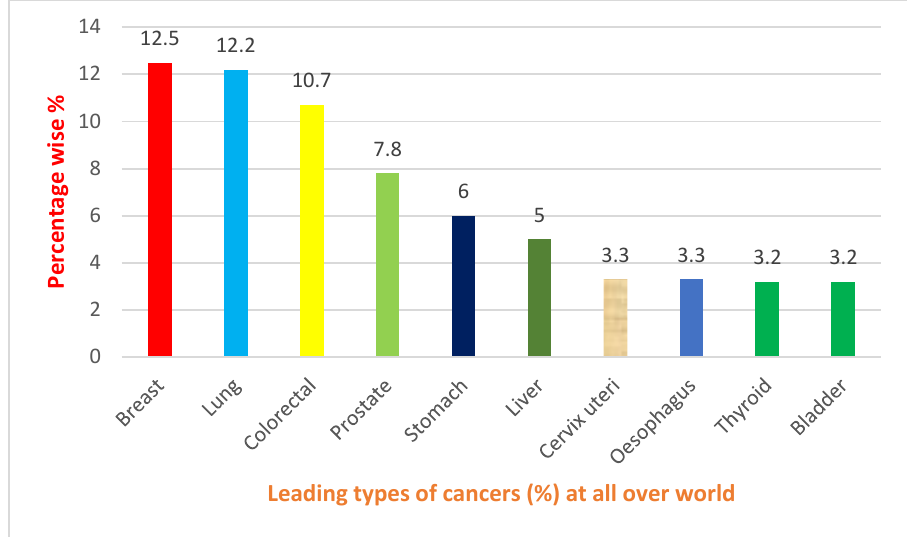
Figure 2. Leading types of cancers worldwide.